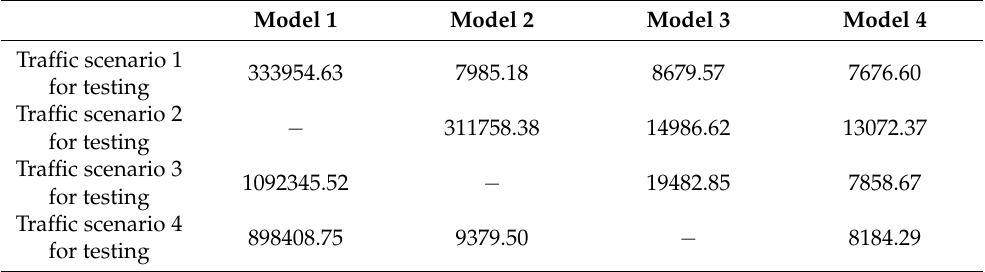
Table 11. Loss time of the four models for each test traffic scenario.